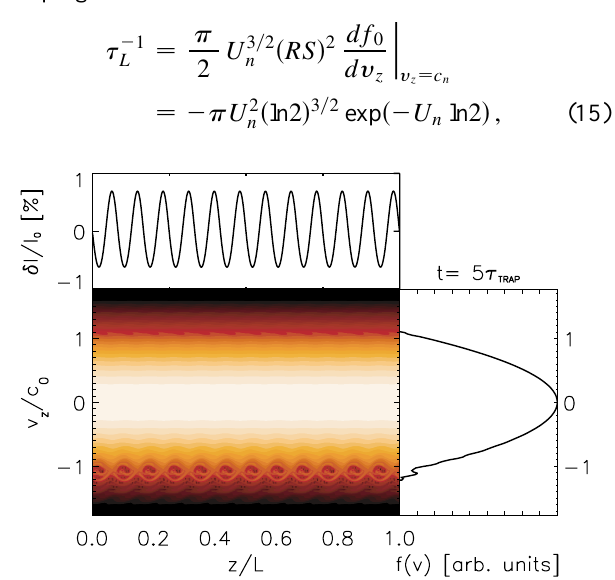
FIG. 3. (Color) Contour plot of the asymptotic distribution function ln f (cid:2) z , y z (cid:3) together with the corresponding line density r L (cid:2) z (cid:3) and the velocity distribution ln f (cid:2) y z (cid:3) obtained from the Vlasov simulation by starting with a current modulation at n (cid:2) 12 and U sc (cid:2) 10